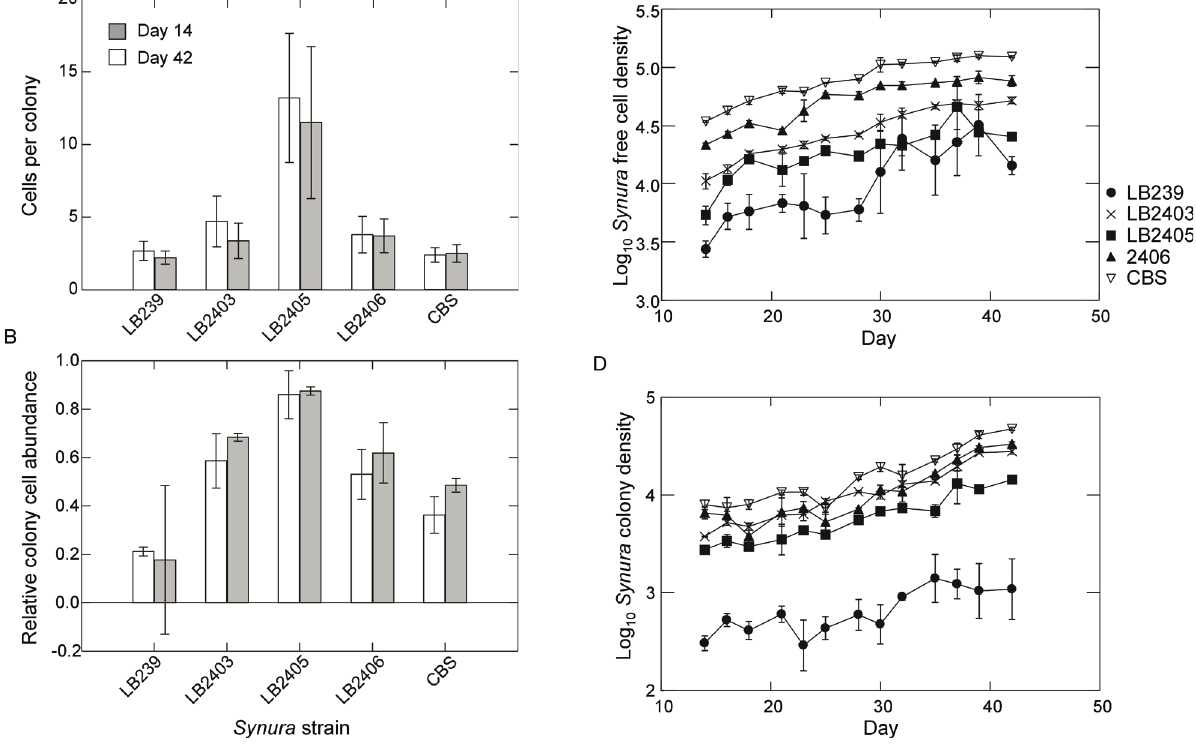
Figure 1. Results of short-term assays examining trait variation among the five Synura strains used in the experiment. Source cultures were maintained under common garden conditions using the same environmental conditions as the main experiment. Individuals of each Synura strain were isolated from one week old cultures and used to establish three replicate monocultures at an initial total cell density of 1500 cells/mL. Monocultures experienced the same environmental conditions (light, temperature and nutrient replacement) and sampling procedures as the main experiment. ( A ) Mean cells per colony of each strain estimated from samples taken on day 14 and day 42 of the assay (shown are means and 95% confidence intervals). ( B ) Mean relative abundance of cells found in colonies estimated from samples taken on day 14 and day 42 of the assay (shown are means and 95% confidence intervals). ( C ) Density of free-living cells over time for each strain. Shown are means (+/- S.E.); original units in numbers of individuals per mL. ( D ) Density of colonies over time for each strain. Shown are means (+/- S.E.); original units in numbers of colonies per